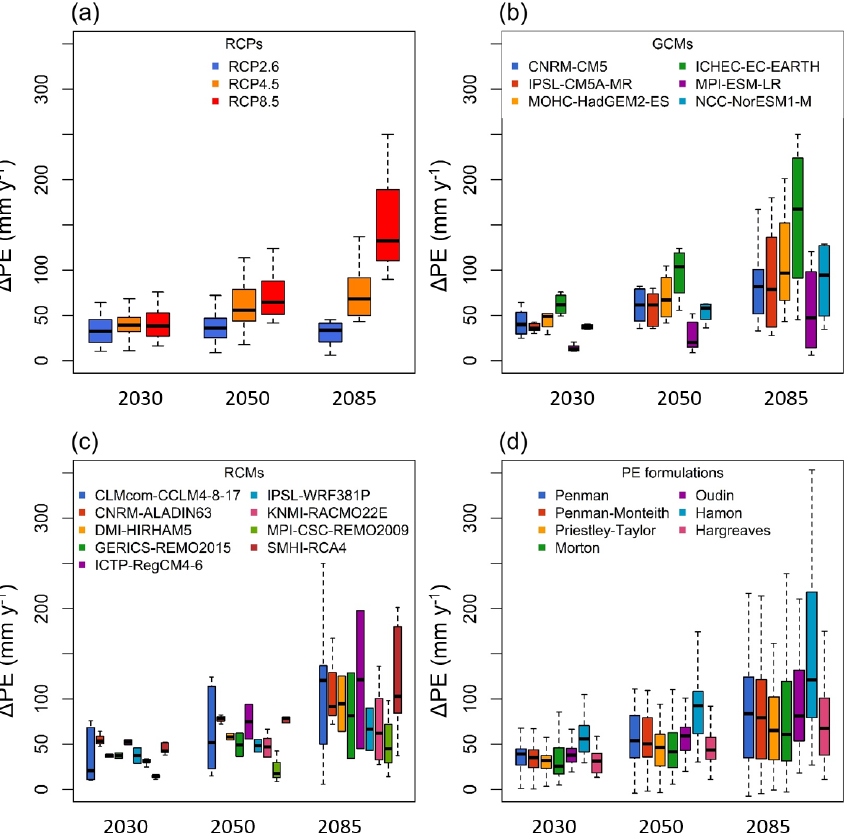
Figure 8. Distribution of annual PE changes across France for three different 30-year periods centered around 2030, 2050 and 2085 for each modeling step: RCPs (a) , GCMs (b) , RCMs (c) and PE formulations (d) . The boxplots represent the 5, 25, 50, 75 and 95 quantiles of the distributions. A boxplot provides information on the variability in the PE anomaly for a given modeling step, whereas the other modeling steps vary across their PE anomaly